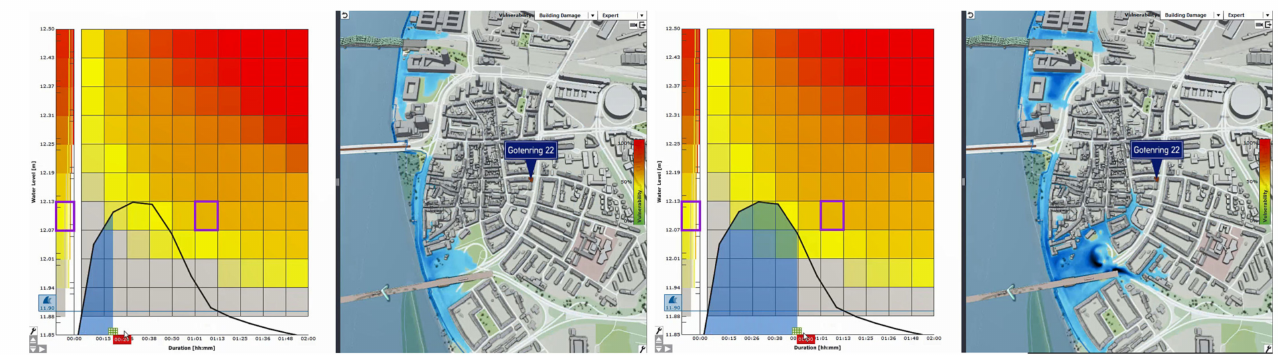
Figure 17. Interactive 2D cell-based chart for the vulnerability to floodwall overtopping showing the selection of different vulnerability-sensitive scenarios: the gray color depicts conditions that are considered safe for the building of interest ( left ); the red color depicts vulnerability up to 100% ( right ).